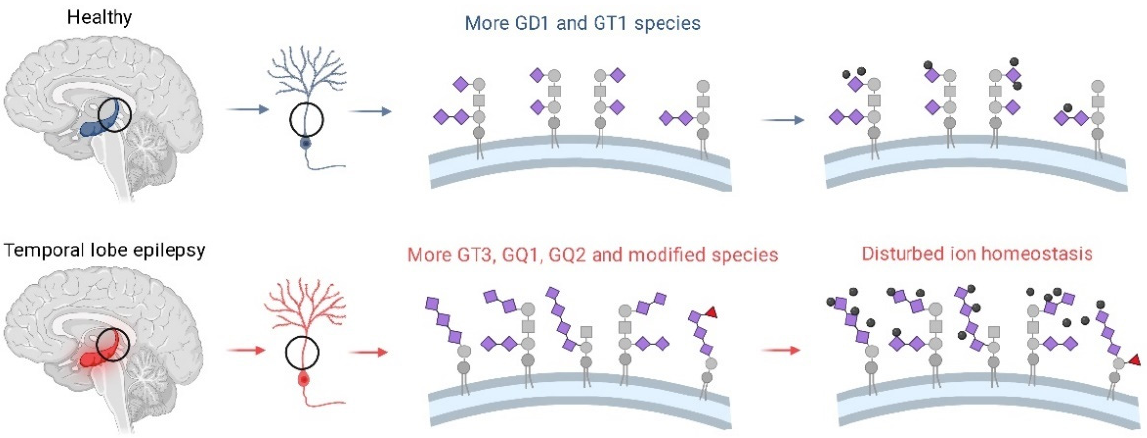
Figure 7. Schematic representation of the presumed relationship between a higher degree of sialylation, ganglioside species modifications and disturbed ion homeostasis occurring in temporal lobe epilepsy.